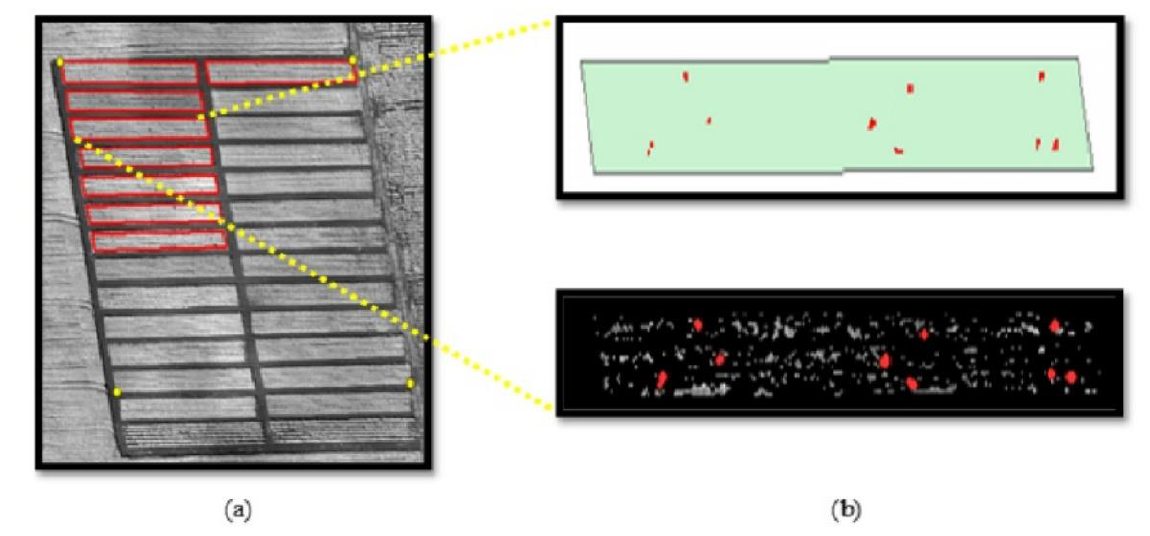
Figure 6. ( a ) Created mask for the experimental plots, ( b ) the result of plots’ extraction.